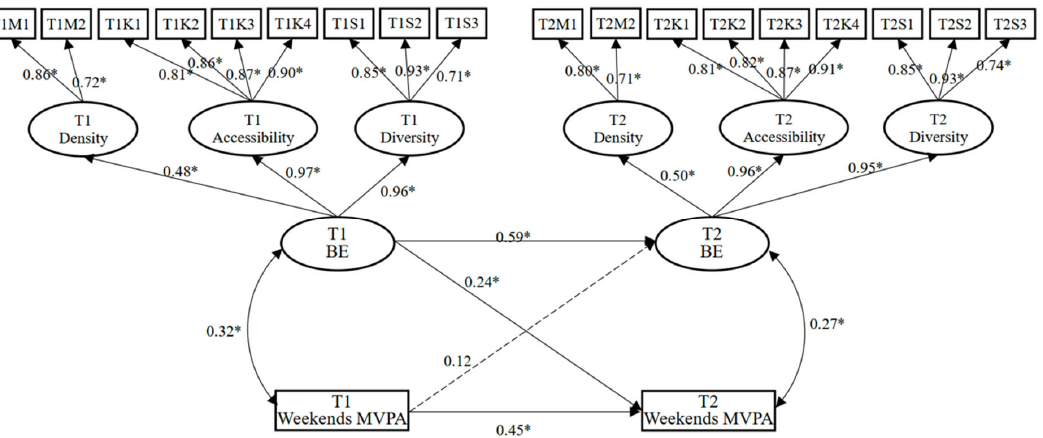
Figure 3. Cross ‐ lagged panel model of built environment (BE) and weekend MVPA. Note: * p < 0.05. The solid line represents significant relationships and the dotted line represents non ‐ significant re ‐ lationships.